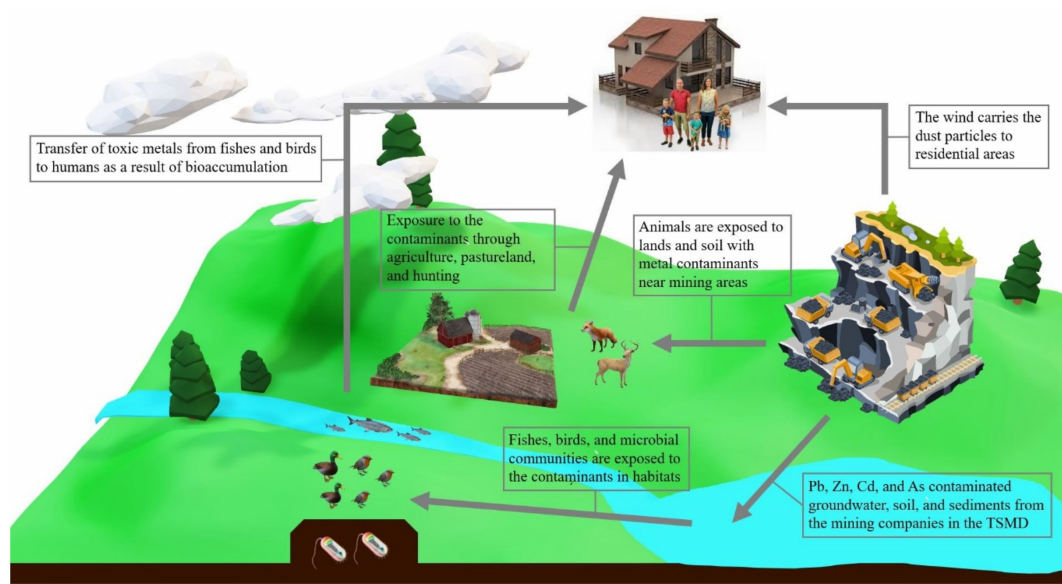
Figure 5. Impacts of Toxic Metals on the Ecosystem. Note: The graphical abstract above shows the impacts of toxic metals on the ecosystem. The toxic metals, such as lead (Pb), zinc (Zn), cadmium (Cd), and arsenic (As), in the wastes from the mining sites and companies in the Tri-State Mining District (TSMD) contaminate the entire ecology from the nature environment to human life; the images in the Figure are eligible for the Fair Use of a copyrighted work